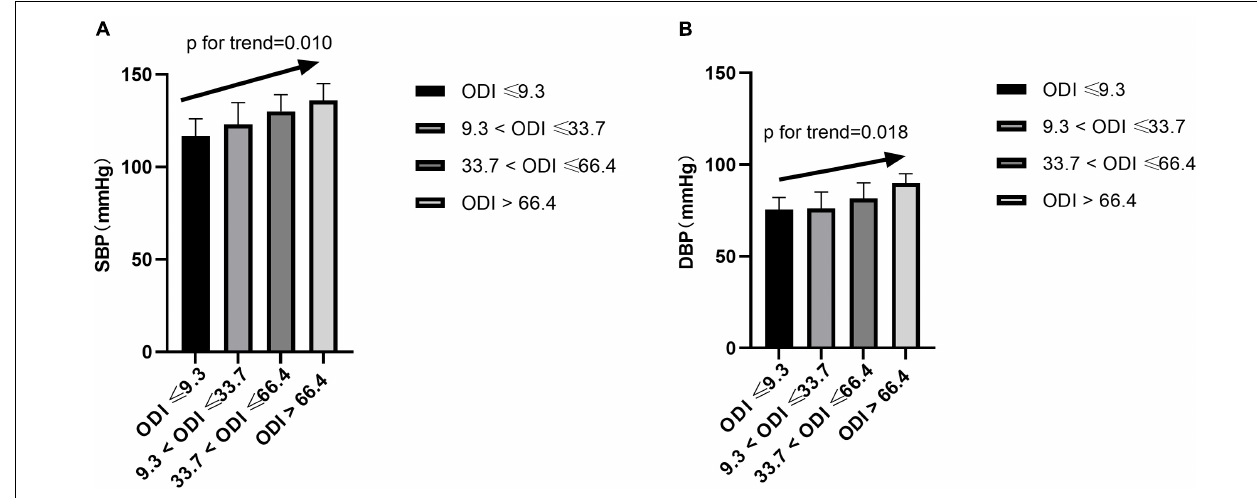
FIGURE 2 | Blood pressure across ODI quartiles. SBP, systolic blood pressure; DBP, diastolic blood pressure; ODI, oxygen-desaturation index.